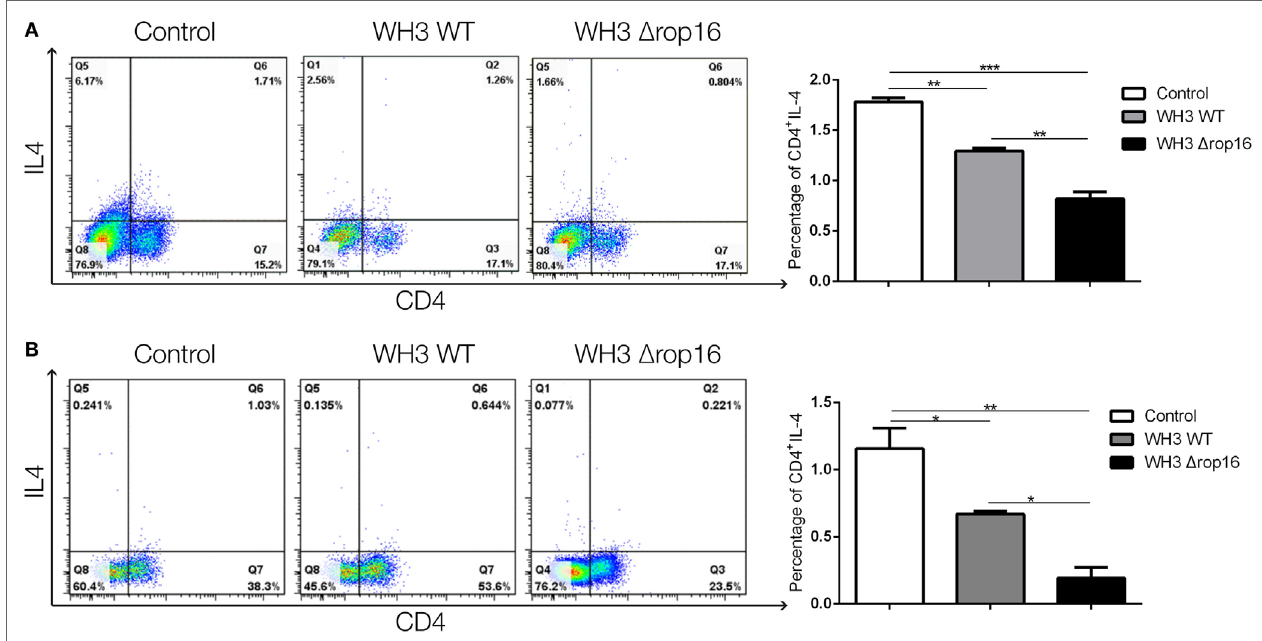
FigUre 7 | Toxoplasma WH3 Δ rop16 strain infection downregulated Th2 response of pregnant mice. The expression of IL-4 in WH3 Δ rop16 group in the spleens (a) and placentas (B) compared to the control group determined with flow cytometry (* p < 0.05, ** p < 0.01, *** p <